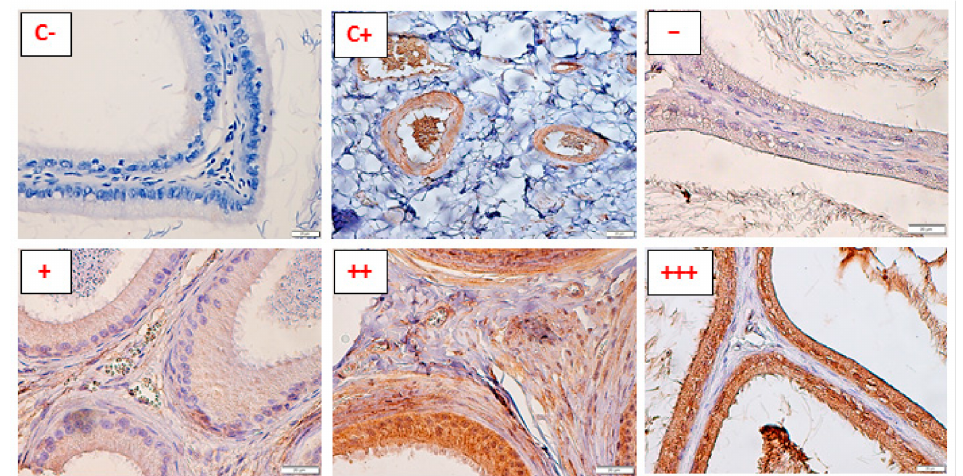
Figure 1. The scale of scoring the intensity of reaction—representative pictures (counterstained with hematoxylin). The white bar on the bottom right of each image represents 20 µ m. (C-) = the negative control (rat caput epididymis, magnification 400 × ); (C+) = the positive control, average staining of the blood vessels (cat caput epididymis, magnification 400 × ); ( − ) = no positive reaction detected (rat caput epididymis, magnification 400 × ); (+) weak positive reaction (cat corpus epididymis, magnification 400 × ); (++) moderate positive reaction (cat cauda epididymis, magnification 400 × ); (+++) strong positive reaction (This was only seen in the epithelium. None of the smooth muscle sections were assessed as having a strong reaction) (rat caput epididymis, magnification 400 ×